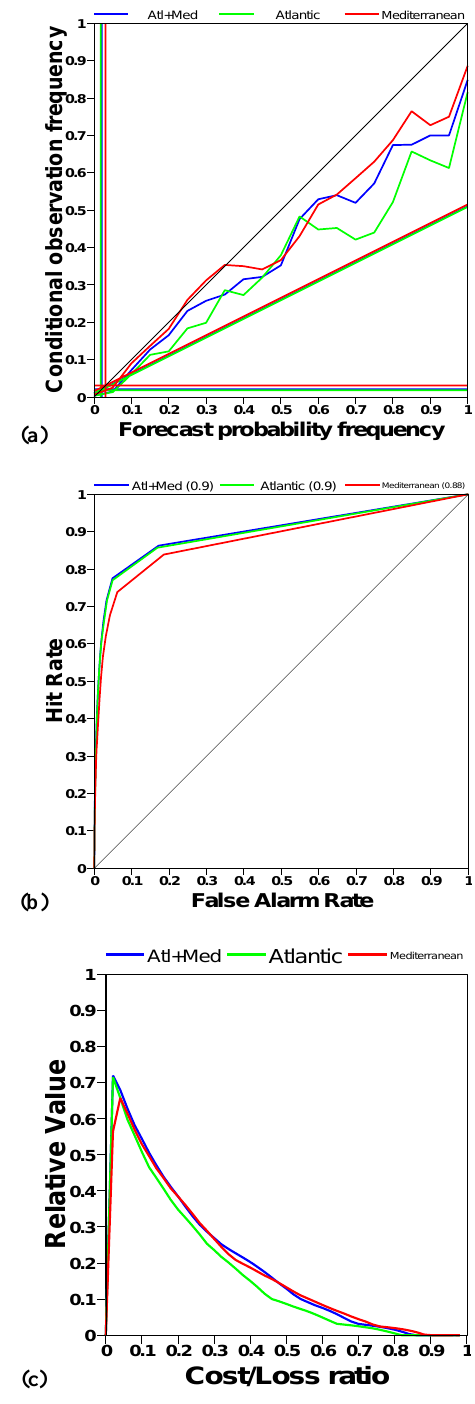
Fig. 4. As in Fig. 2, but for 2007 boreal autumn (September- October-November